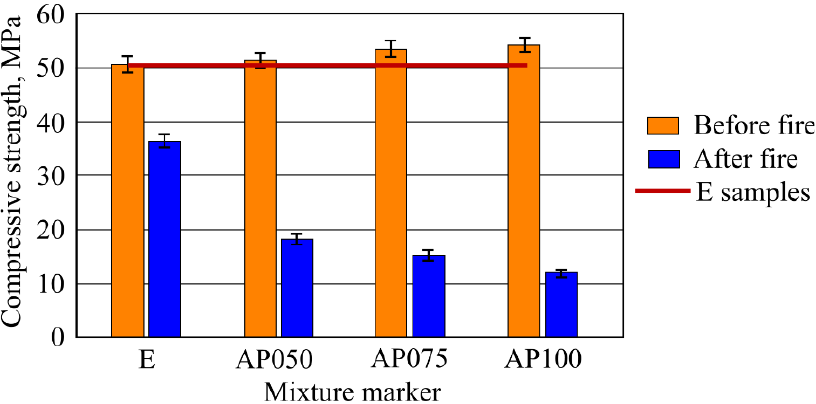
Figure 12. Results of compressive strength (before and after fire effect) of the samples.